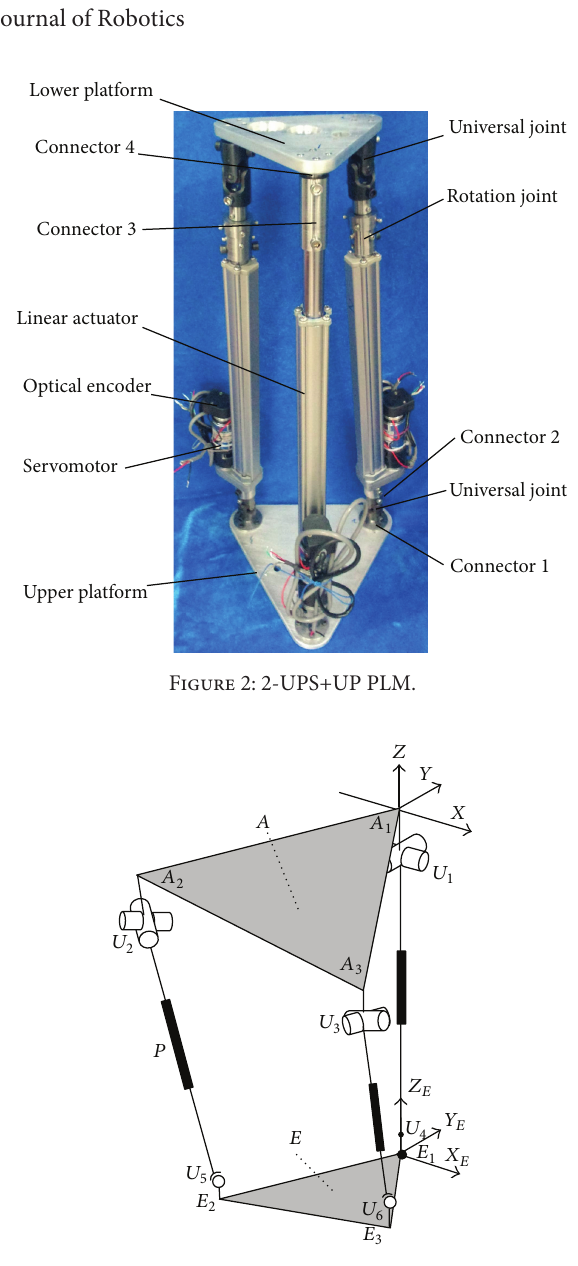
Figure 3: Structure sketch of 2-UPS+UP PLM.